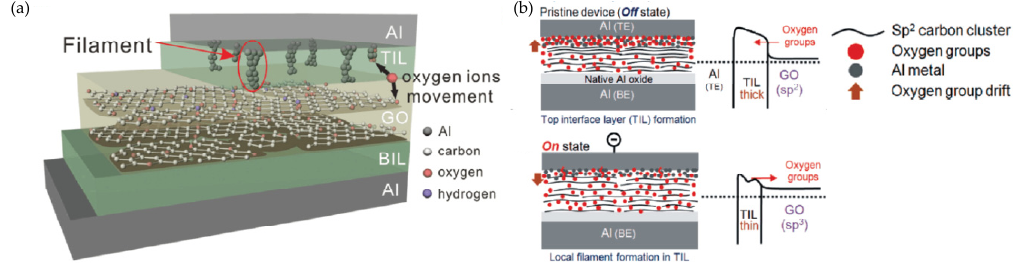
Figure 6. ( a ) Schematic of oxygen ion movement model of Al / GO / Al RRAM device. ( b ) Schematic of the proposed bipolar RS model for Al / GO / Al crossbar memory device [124,143] .